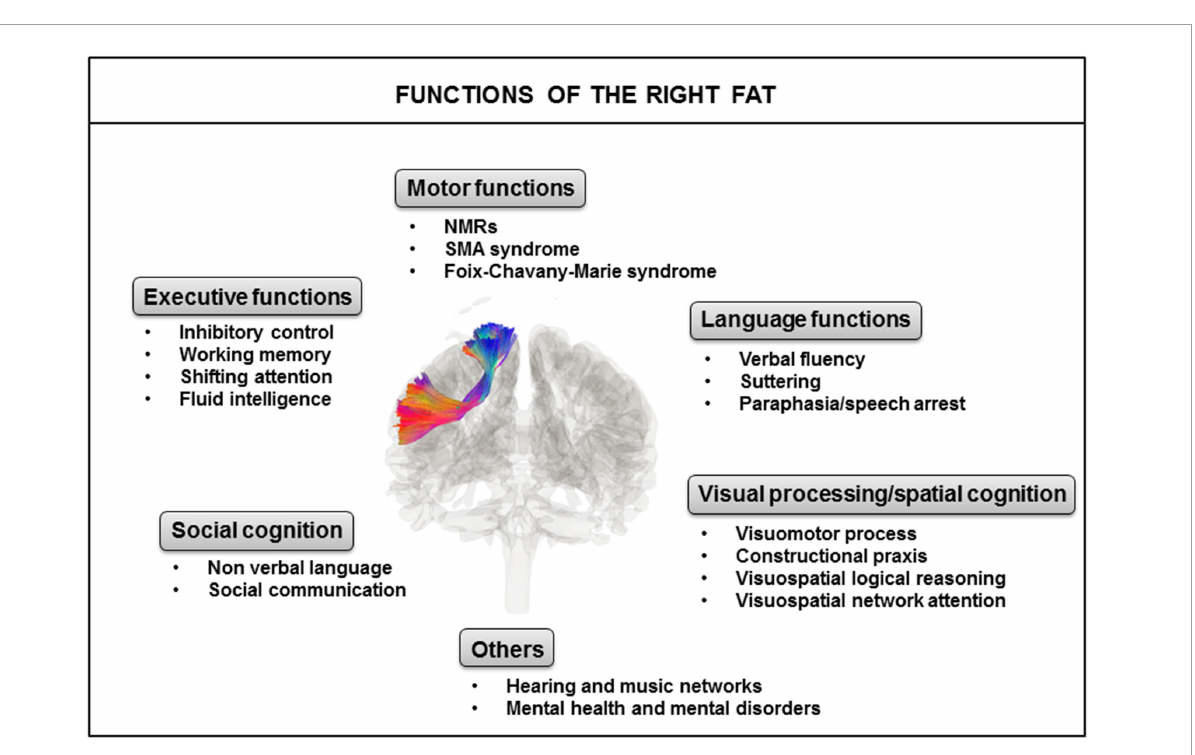
FAT damage was associated with speech apraxia, an association never previously observed. Further studies are required to evaluate the role of the right FAT in this speech